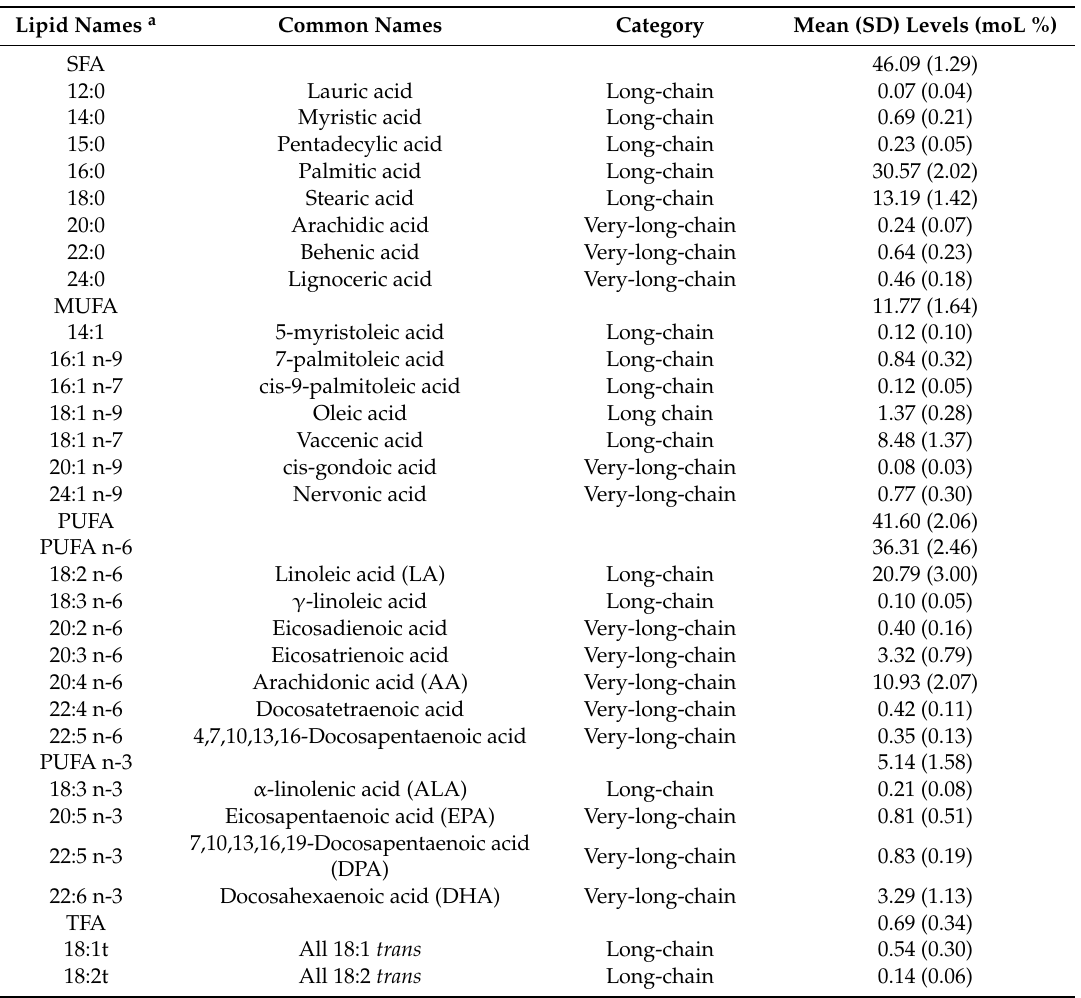
Table 1. The lipid names, common names, categories, and mean (SD) levels (moL %) of plasma phospholipid fatty acid profiles measured in the matched case-control study of the Women’s Health Initiative (1994–2005) ( N =